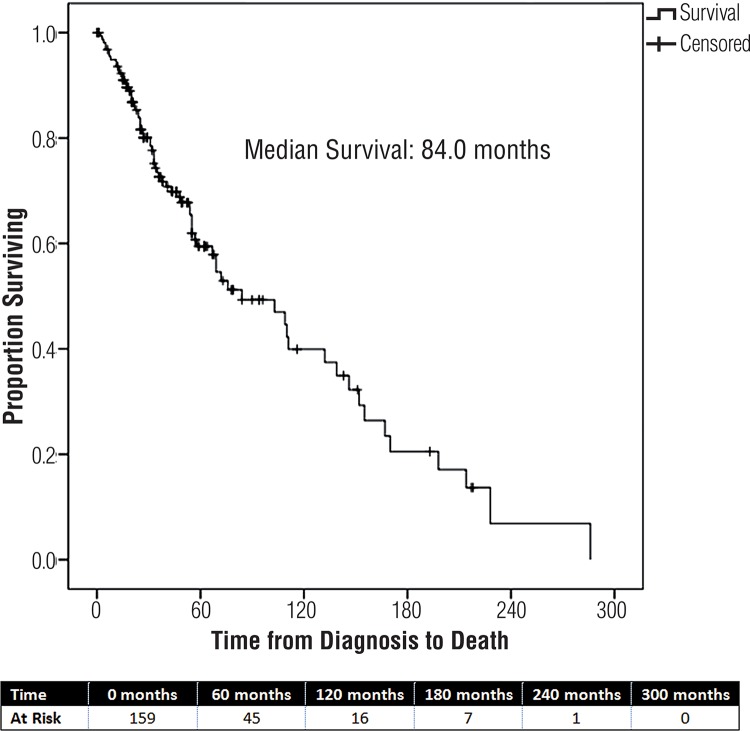
Survival from time of diagnosis.